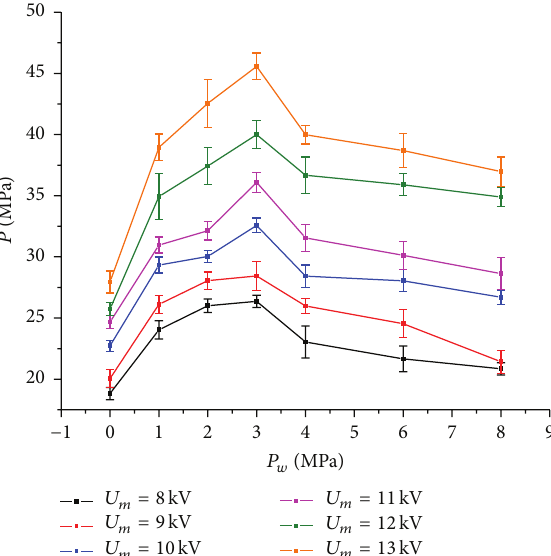
Figure 9: Plot of shock-wave peak pressure at 0.5